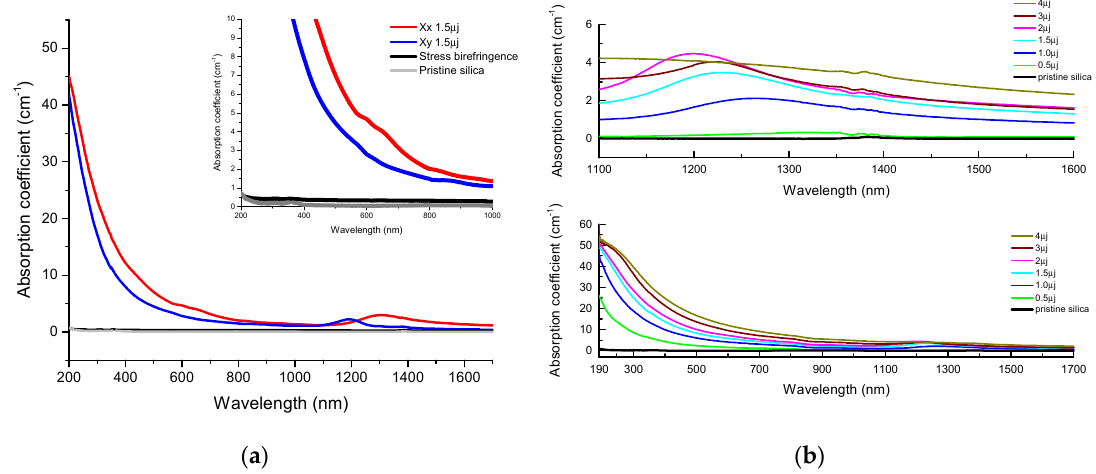
Figure 4. ( a ) Comparison of absorption coe ffi cient k abs ( λ ) spectra for di ff erent waveplates together with pristine silica. Black line is for the stress-engineered waveplate (a half waveplate at 450 nm) whereas red and blue lines are for nanogratings-based waveplates written in Xx and Xy configurations. ( b ) Absorption coe ffi cient k abs ( λ ) spectra of nanogratings-based waveplates for di ff erent pulse energies. Note that each waveplate was annealed for 2 hours at 600 ◦ C prior to